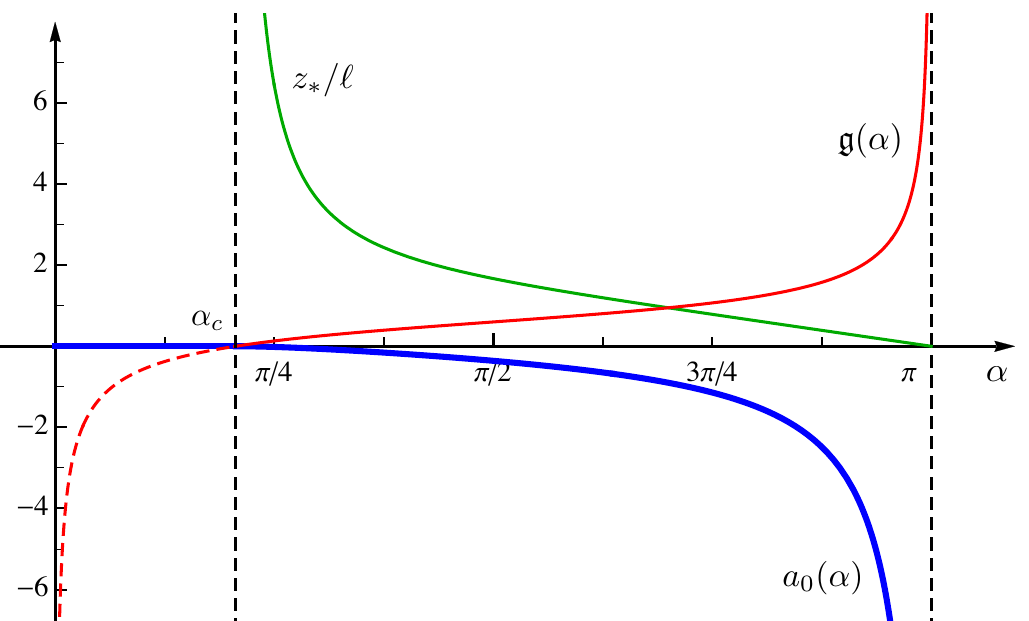
Figure 10 . In(cid:12)nite strip adjacent to the boundary: the red curve is g ( (cid:11) ) in (5.4), which is positive for (cid:11) > (cid:11) c and negative for (cid:11) 6 (cid:11) c , being (cid:11) c given by (5.6). The solid green curve corresponds to z (cid:3) =‘ obtained from (5.3) and it diverges as (cid:11) ! (cid:11) + . The solid blue line is the O (1) term in the c expansion (5.9) of the area A [^ (cid:13) "